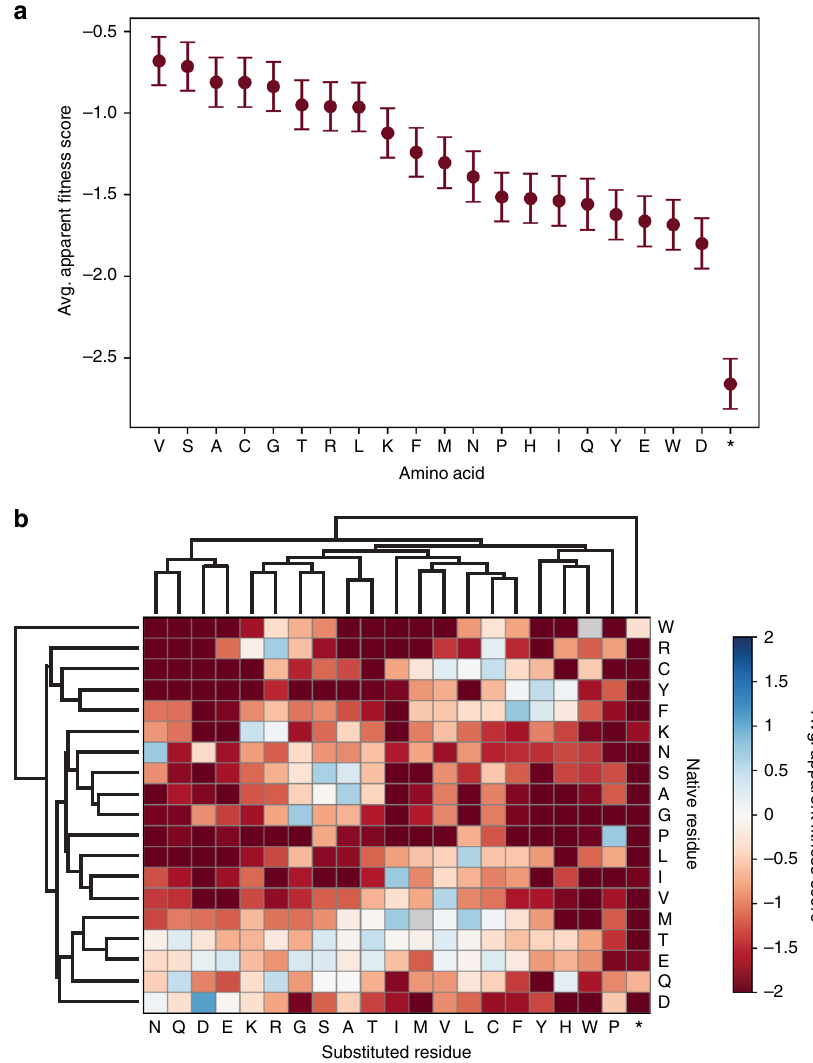
Fig. 7 Average AFS values ( n = 3) of amino acids across MS2 CP. a The average AFS and standard error values are indicated for every native residue mutated to the indicated amino acid. b Averages from part A are separated by native residue and clustered by